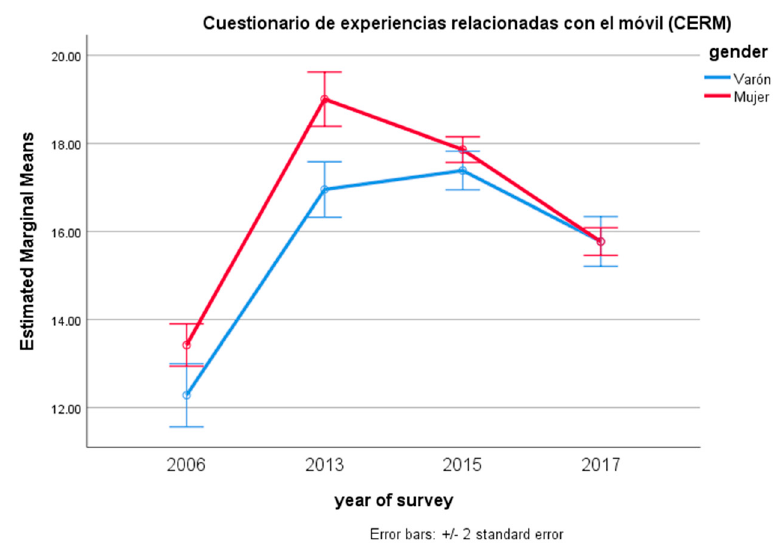
Figure 1. Estimated marginal means of Cuestionario de Experiencias Relacionadas al Móvil (CERM) for year of survey and gender. Int. J. Environ. Res. Public Health 2018 , 15 , x